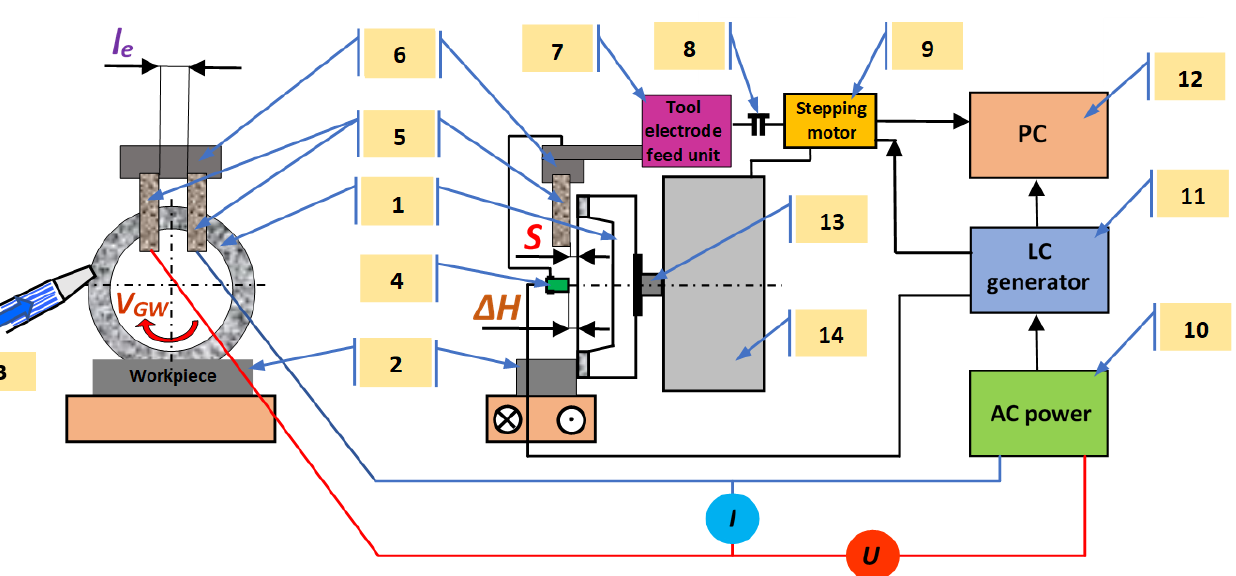
Figure 3. The scheme of a stand for grinding wheels dressing using the ECDGW-AC method: 1—grinding wheel, 2— workpiece, 3—electrolyte supplying nozzle, 4—inductive sensor, 5—tool-electrode, 6—electrode holder, 7—tool-electrode feed unit, 8—guide-screw, 9—stepping motor, 10—AC power unit, 11—LC generator, 12—computer, 13—spindle, 14— headstock, l e —distance between electrodes, ES —electrolyte solution of specially selected chemical compounds, S —inter- electrode gap, ΔH —the thickness of the grinding wheel layer removed in the ECDGW-AC process.